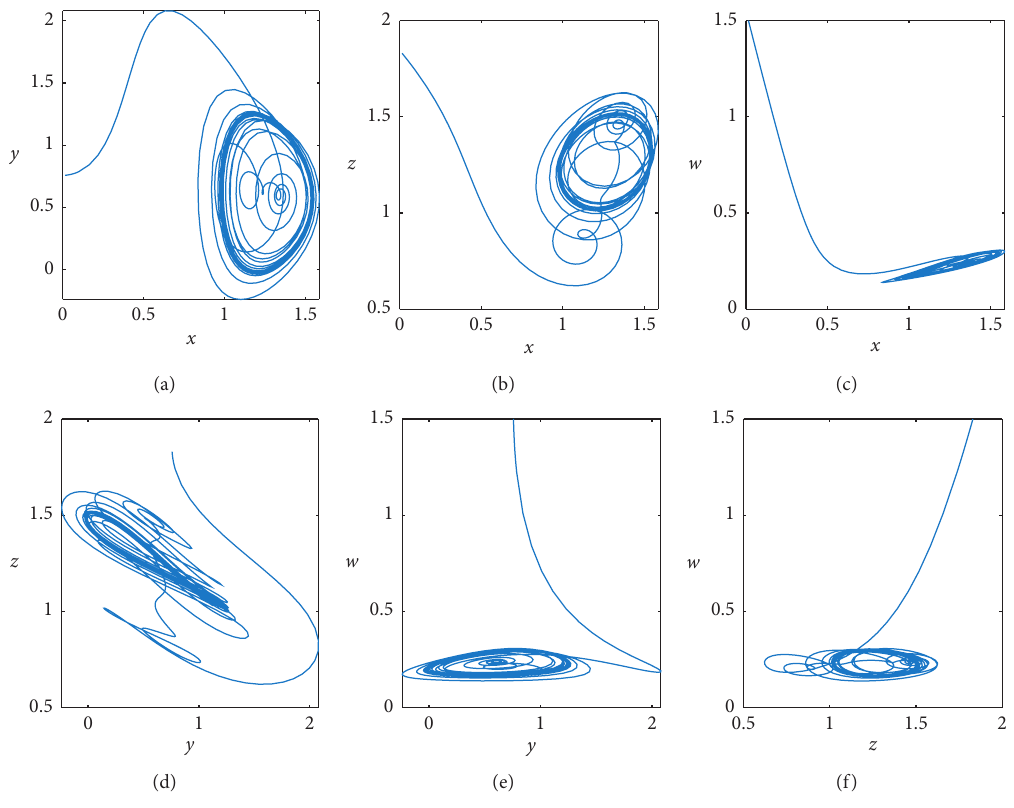
Figure 2: Two-dimensional plane chaotic attractor phase diagram of system